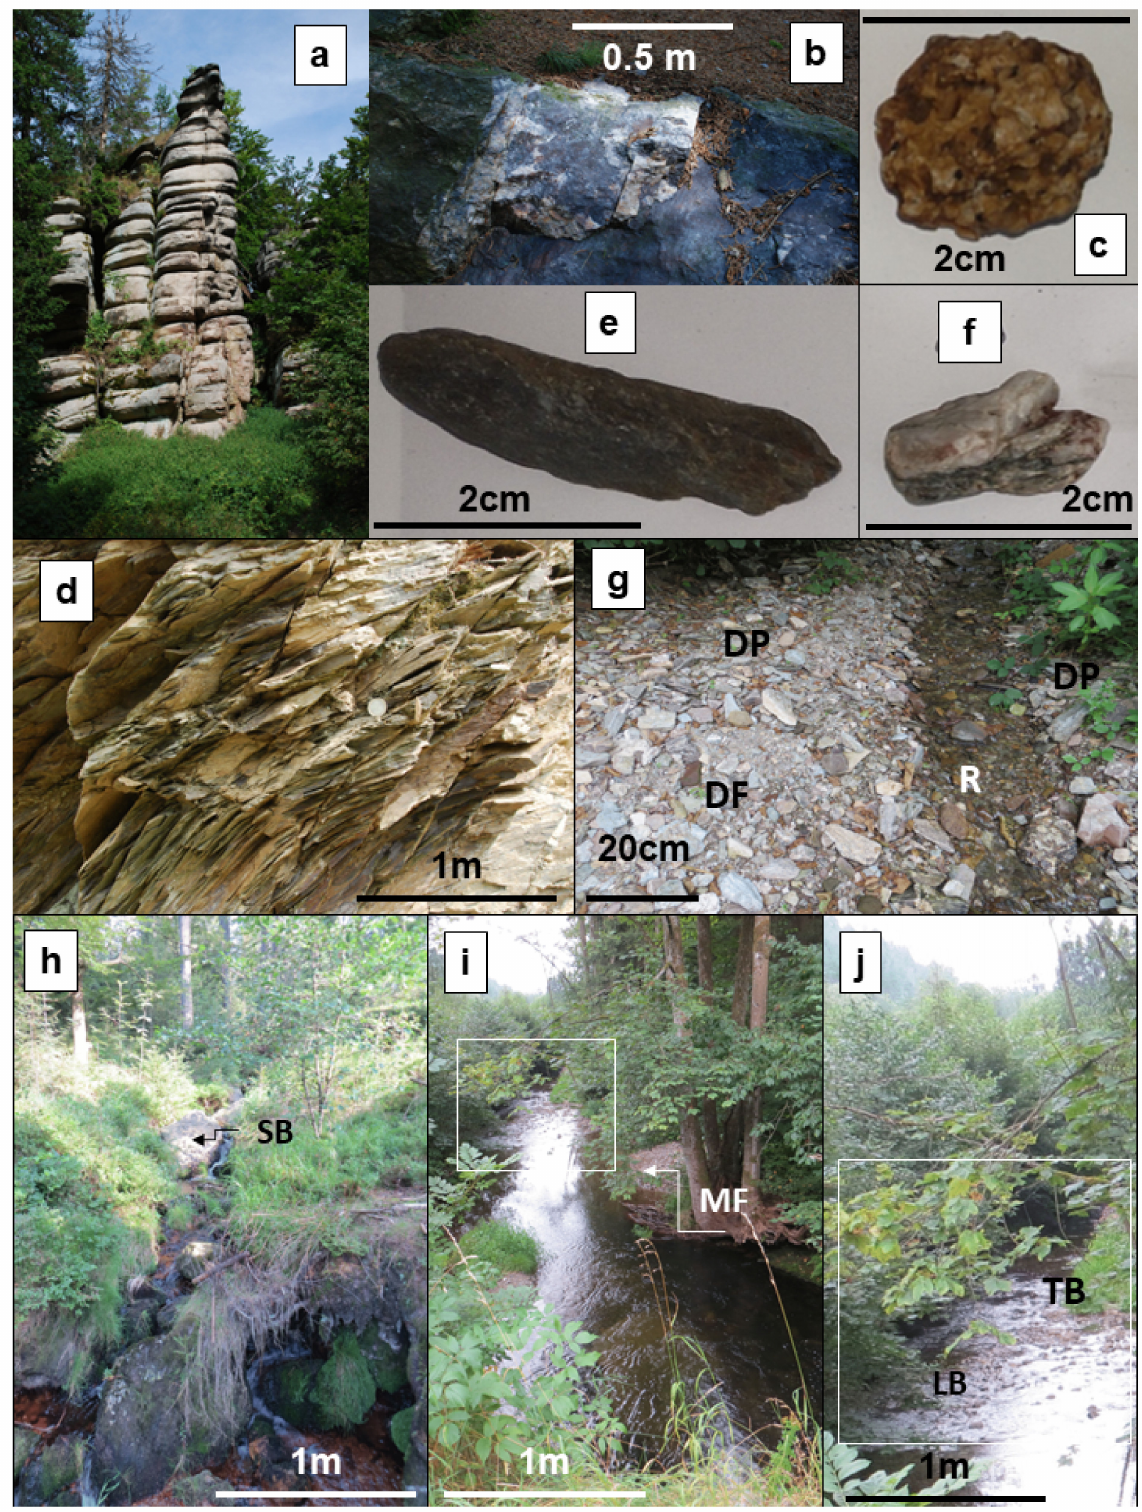
Figure 4. Characteristic landforms and sediments along the talweg of the Steinach River at the western edge of the Fichtelgebirge Mts. ( a ) Towers of woolsacks on the Fichtelgebirge summits (see also the Ochsenkopf Summit) with characteristic subhorizontal layered onion-shell fractures and